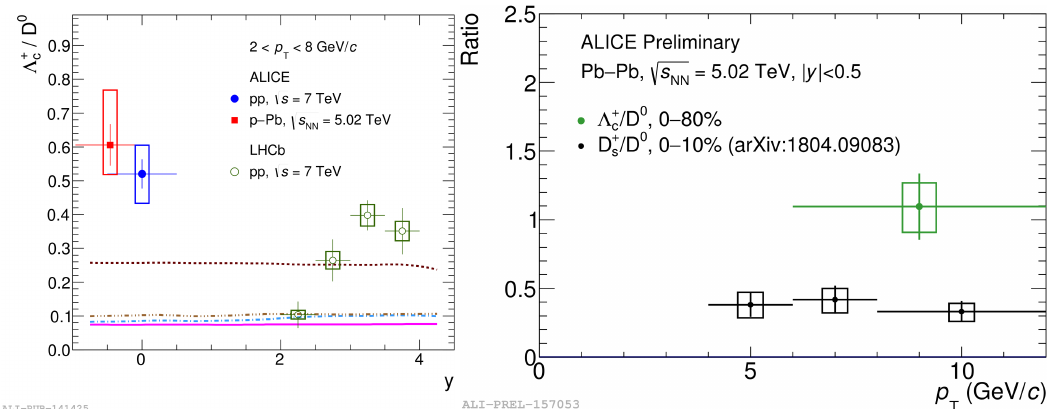
Figure 14. ( Left ) Λ _ c + /D 0 ratio measured in pp and p–Pb collisions by ALICE as a function of y , compared to LHCb results in a different rapidity region [37]; and ( Right ) Λ + c /D 0 ratio vs. p T measured by ALICE in